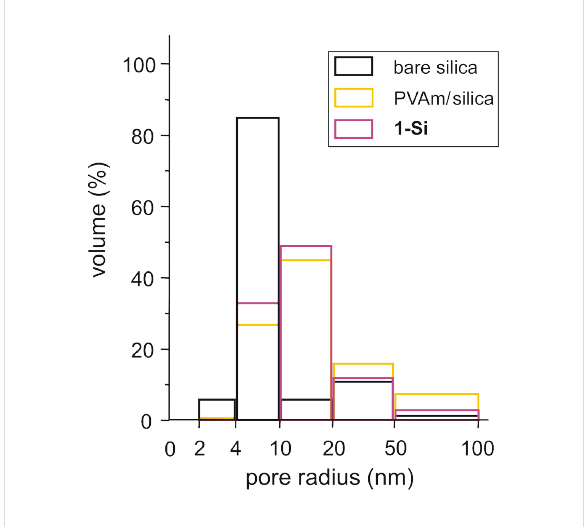
Figure 3: Pore-size distribution of bare silica, PVAm/silica and 1-Si .